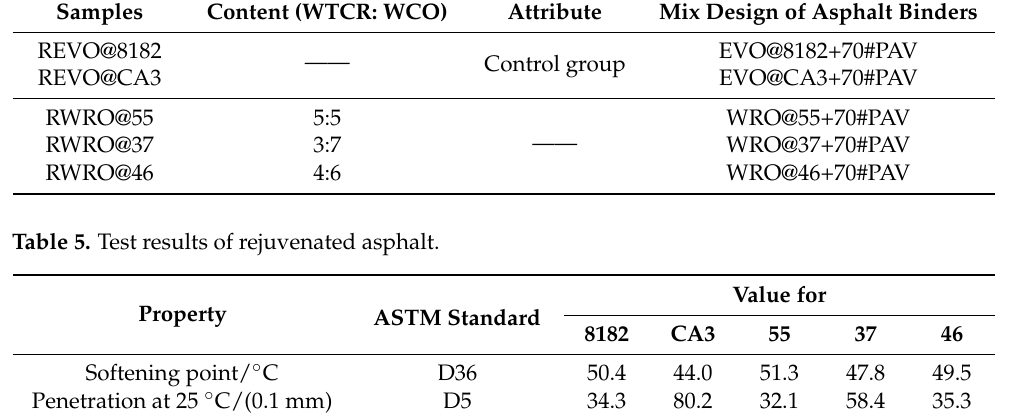
Figure 1. Brief diagram of laboratory self ‐ made reaction device.